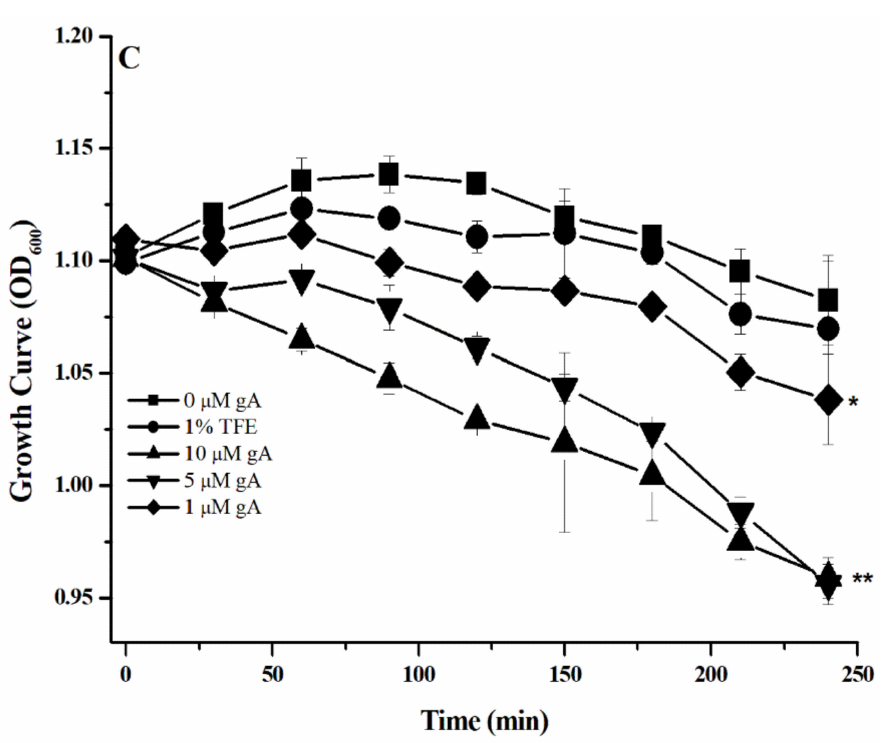
Figure 1. The growth curve of S. aureus in the presence of gramicidin A 0, 1, 5, and 10 µ M, and 1% TFE without gramicidin A, at the different growth phases, ( A ) lag phase, ( B ) elongation phase, and ( C ) stationary phase, respectively. ( n = 3, * p ≤ 0.05, ** p ≤ 0.001, related to 0 µ M